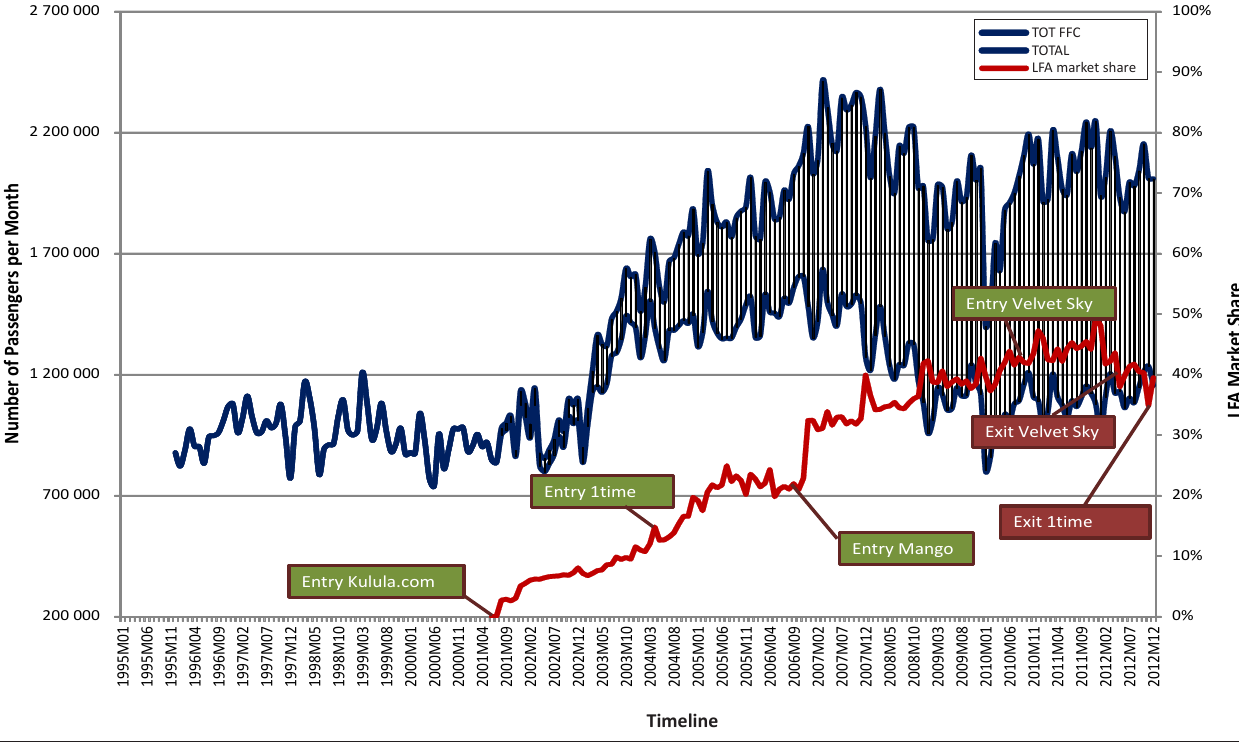
FIGURE 4: Passenger trends on the ‘Golden Triangle’, including Low-Cost Carriers market share growth (total scheduled domestic arrivals and departures).